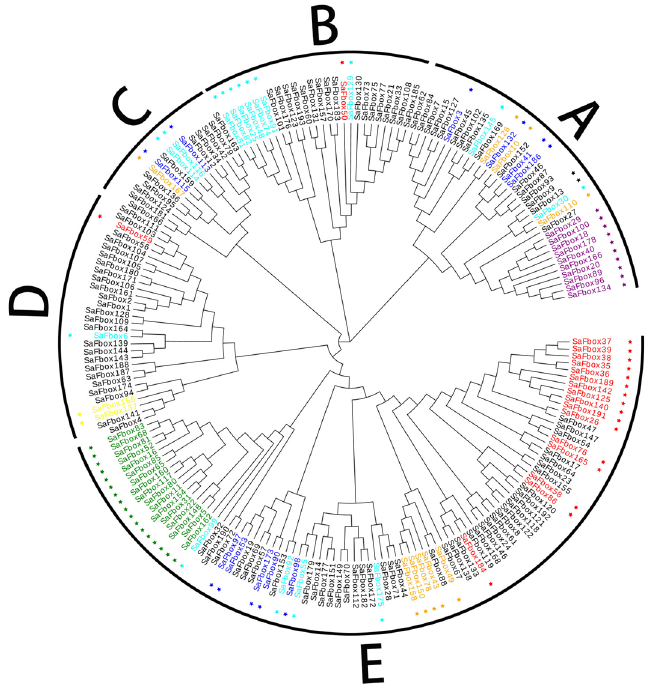
Figure 2. Analysis of phylogenetic relationships. The full amino acid sequences of 193 SaFbox proteins were aligned and a phylogenetic tree was constructed with MEGA7.0. Clades were divided into six groups (A–E). Different subfamilies are presented in different colors. Blue represents FBL subfamily, cyan (FBO), red (FBA), purple (FBP), orange (FBK), yellow (FBK), green (FBT), dark (FBX) and light green (FBW).